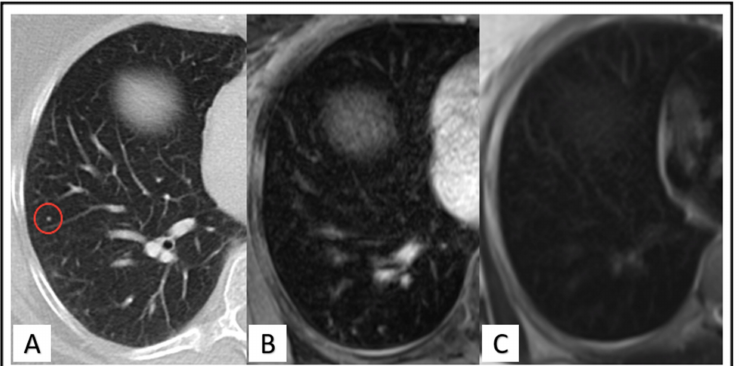
Figure 2. Images of a 46-year-old woman. Four-millimeter lung nodule located in right lower quadrant (red circle) identified on the CT image ( A ) but not recognizable in VIBE ( B ) nor HASTE ( C )